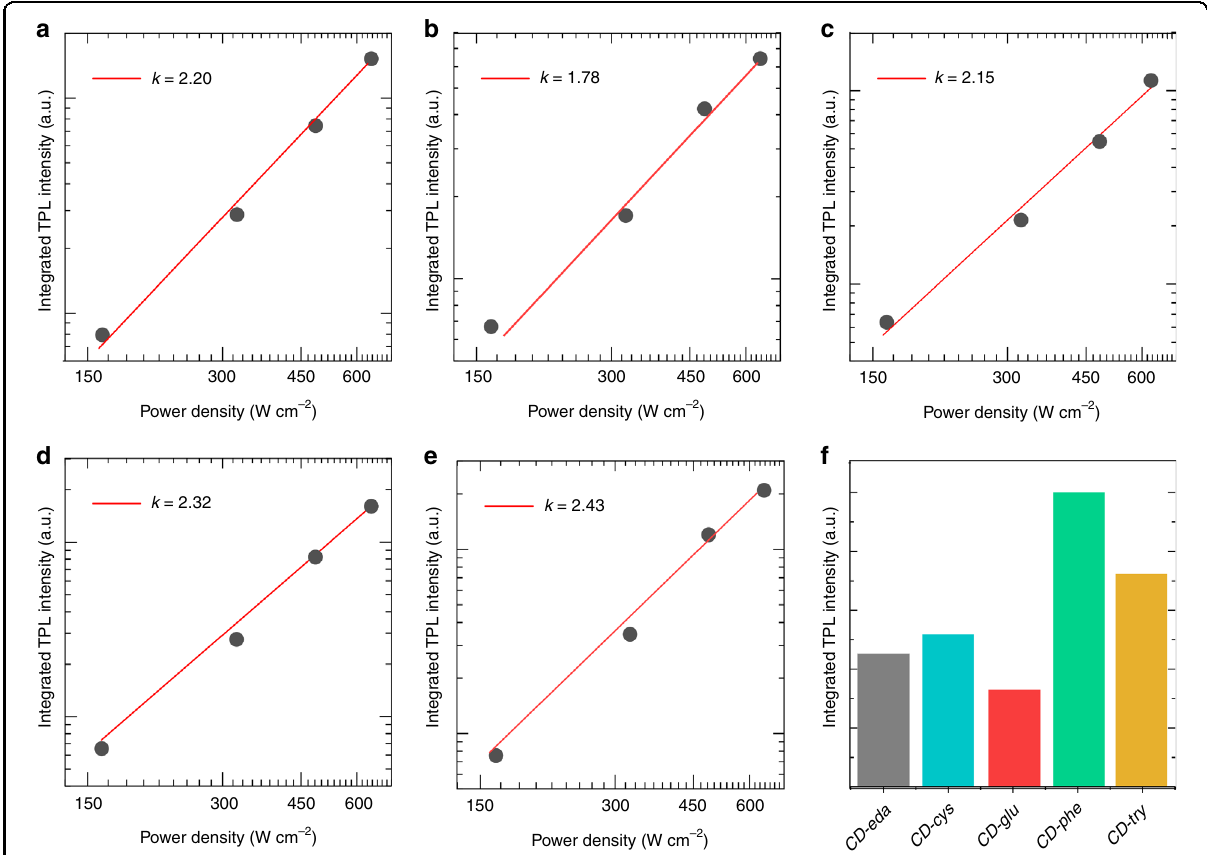
Fig. 7 Two-photon excited luminescence of CDs. a – e Dependence of the integrated intensities of TPL on the power densities for excitation of the fi ve CD samples: a CD-eda , b CD-cys , c CD-glu , d CD-phe , and e CD-try . f Comparison of integrated TPL intensities for fi ve CD